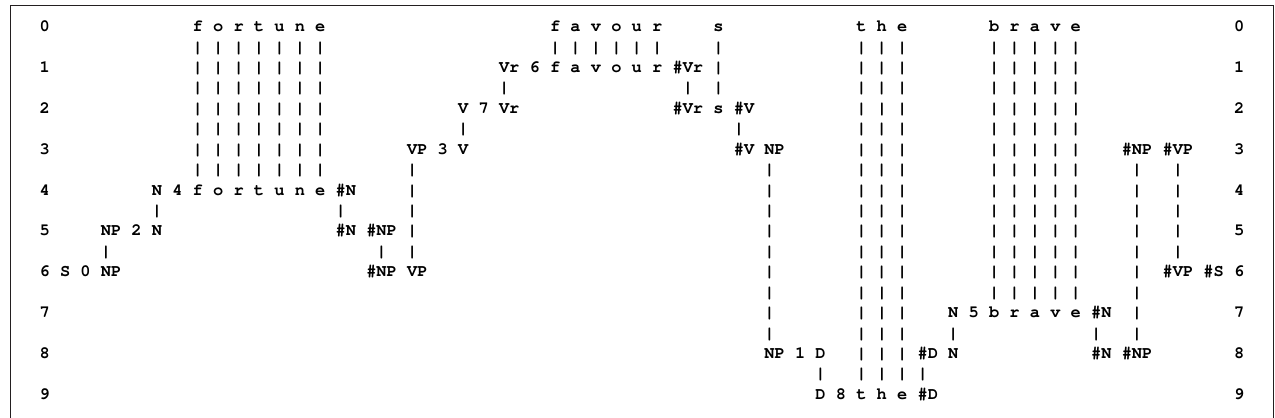
FIGURE 2 | The best multiple alignment produced by the SP computer model with a New pattern representing a sentence to be parsed and a repository of user-supplied Old patterns representing grammatical categories, including words. In the multiple alignment, the New pattern appears in row 0 and some of the Old patterns supplied to the system appear in rows 1 to 9, one pattern per